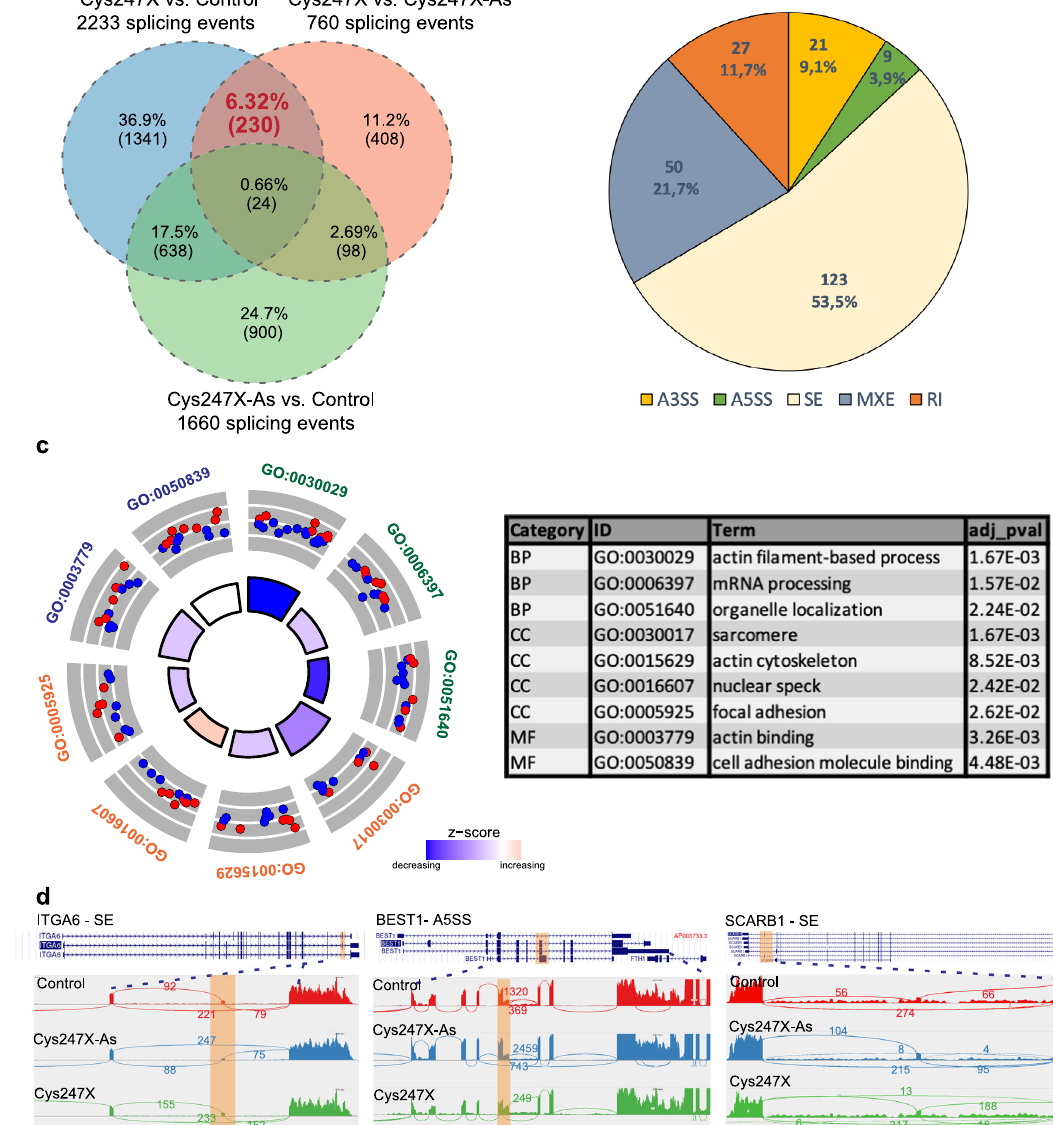
Fig. 10 Identi fi cation of alternate splicing in hiPSC-derived RPE cells from PRPF31 patients. a Venn diagrams comparing alternate splicing changes identi fi ed in iRPE cells and considered as signi fi cant (deltaPSI ≥ 10%, FDR ≤ 0.05) between Cys247X vs Control, Cys247X vs Cys247X-As and Cys247X-As vs Control. The number of alternate splicing events of interest are indicated in red and occurred in 152 genes. b Pie chart from rMATs analysis showing that a majority of splicing events corresponded to skipped exons. A5SS and A3SS, alternative 5 ′ and 3 ′ splice sites; SE, skipped exons; RI, retained introns; MXE, mutually exclusive exons. c Circular visualization of selected GO enriched pathways from the identi fi ed 152 genes with alternative splicing events. Down- (blue dots) and up-regulated genes (red dots) within each GO pathway are plotted based on logFC. z score bars indicate if an entire biological process is more likely to be increased or decreased based on the genes it comprises. Green, Biological Process; orange, Cell Compartment; blue, Molecular Function. The table shows pathway identity number (ID), associated pathway name (Term), gene count from the analyzed dataset and the adjusted P value ( adj_pval ). The different categories of pathways are BP, Biological Process; CC, Cell Compartment; MF, Molecular Function. d Sashimi plots for the indicated genes representing the alternate splicing events in iRPE cells derived from Control (green), Cys247X-As (blue) and Cys247X (red). Data are representative of the replicates for each experimental group. Orange highlights in the sashimi plots indicate the alternative splicing events and numbers correspond to the number of junction reads for each event. ITG6A: Integrin Subunit Alpha 6; BEST1: Bestrophin 1; SCARB1: Scavenger Receptor Class B Member